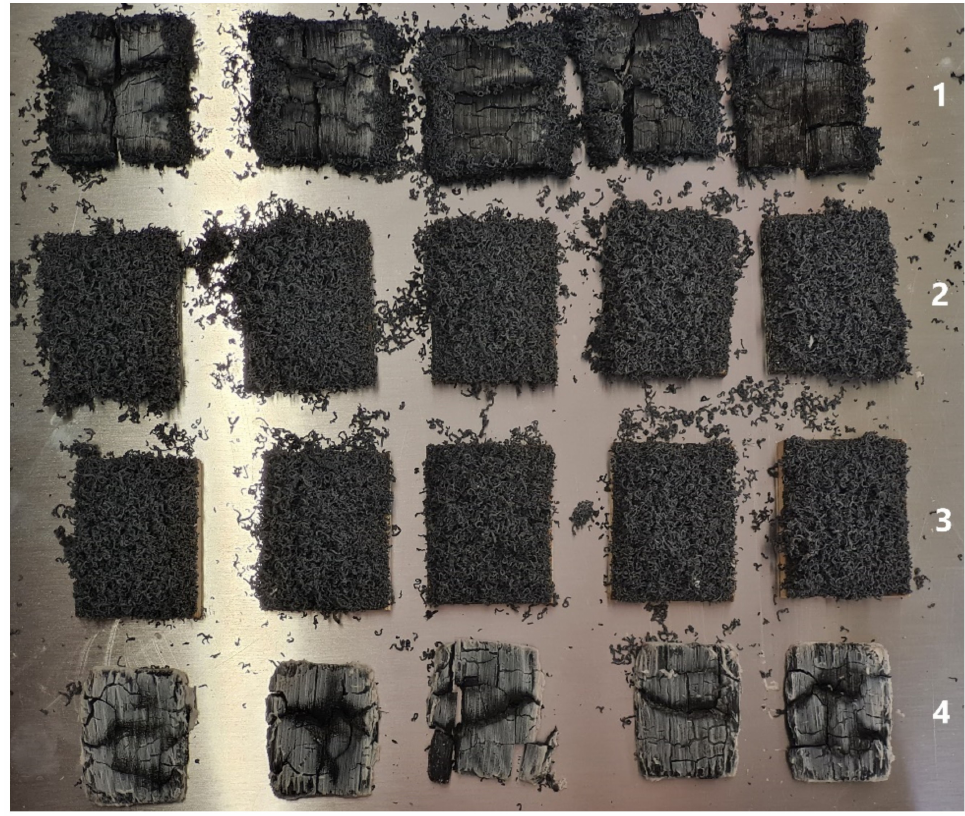
Figure 2. Picture of samples after the experiment (1—side, 2—top + side, 3—top,